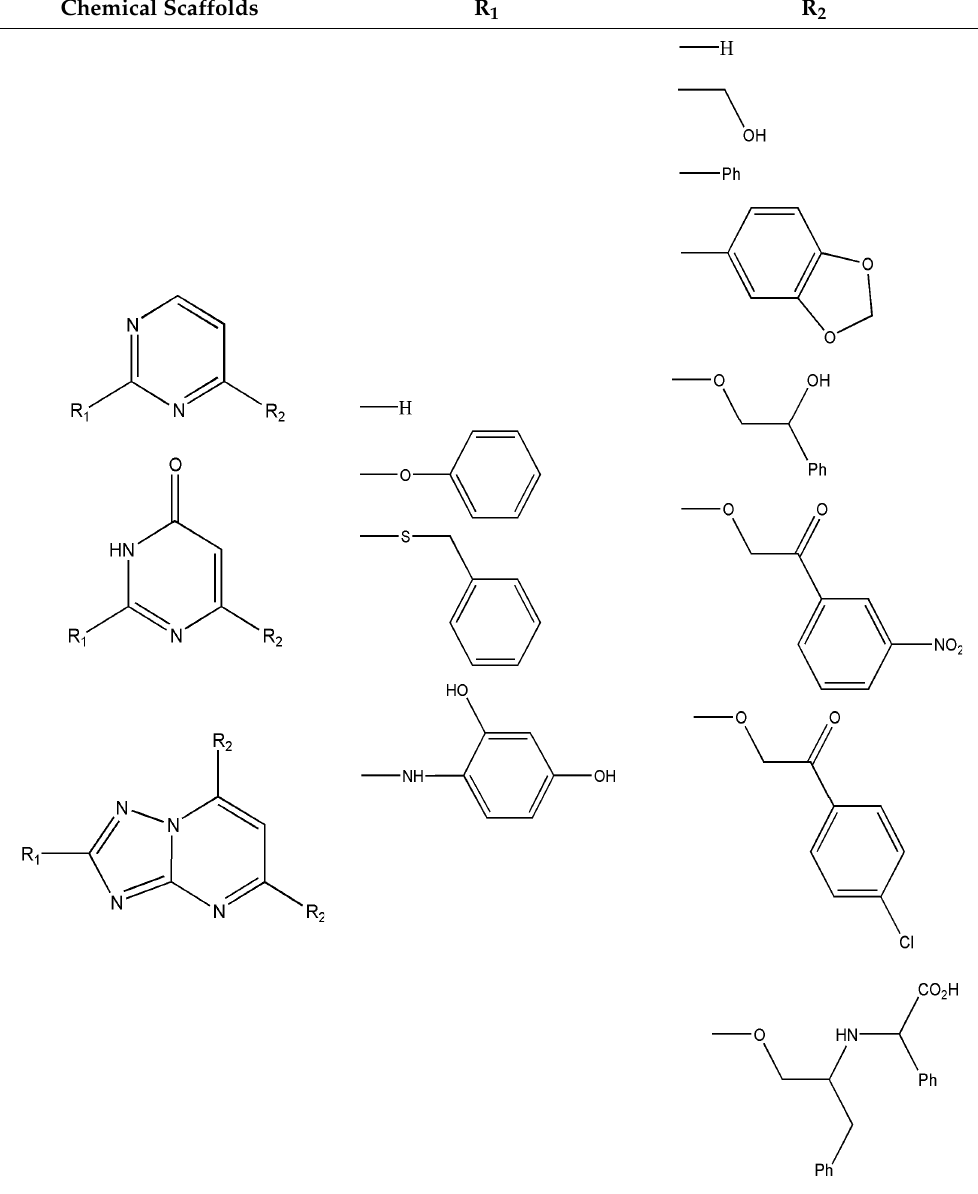
Table 5. Scaffolds and fragments used for the generation of the virtual